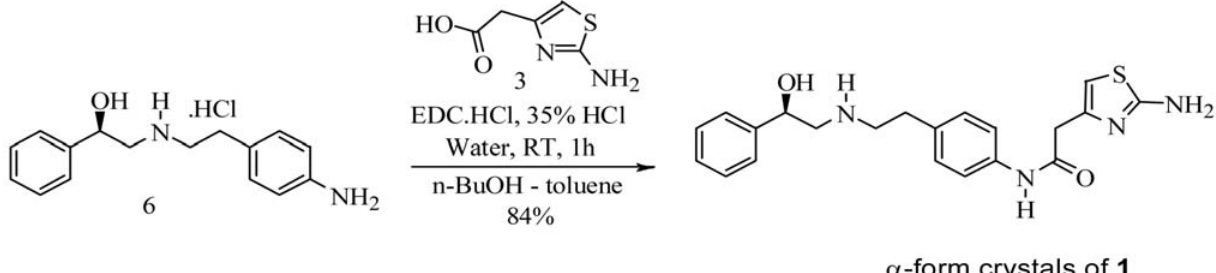
Scheme 4. Direct isolation of α - form crystals of Mirabegron ( 1